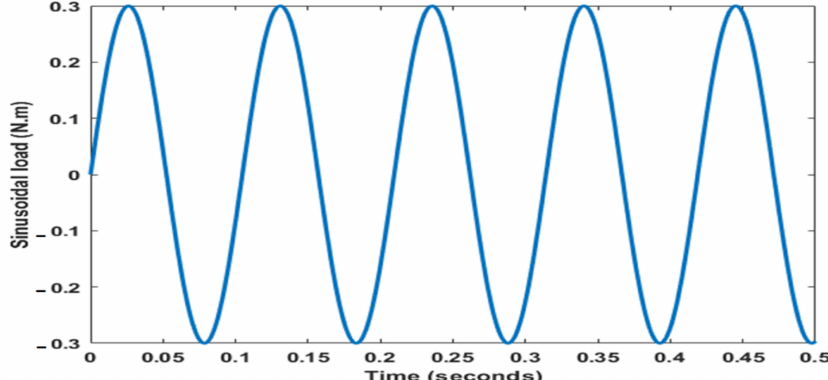
Figure 9. The applied sinusoidal